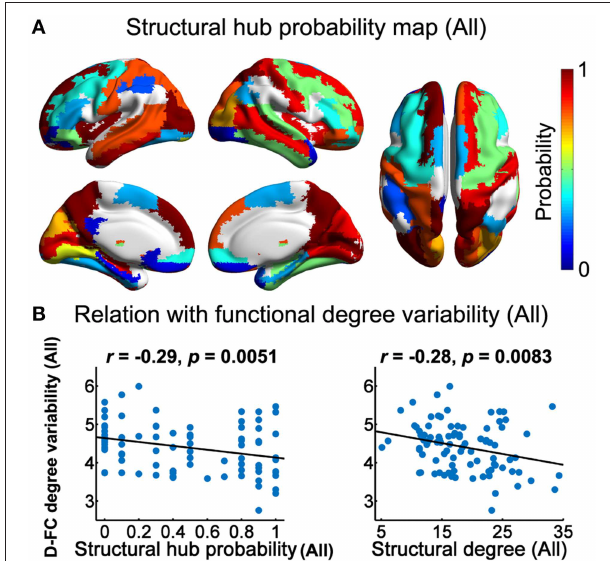
FIGURE 5 | Structural brain hubs and their associations with D-FC networks. (A) Structural hub probability map for all participants, which was generated by counting the occurrence probability as structural hubs across participants for each region. (B) Scatter plots showing the across-node relationship between temporal variability of functional degree centrality in the D-FC networks and structural hub probability (left) and structural degree centrality (right). Given the discrete values of structural hub probability, Spearman’s correlation analysis was used. D-FC, dynamic functional